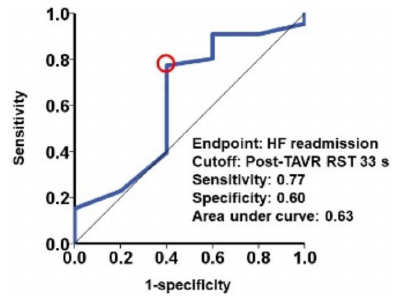
Figure A2. Cutoff of RST to predict heart failure